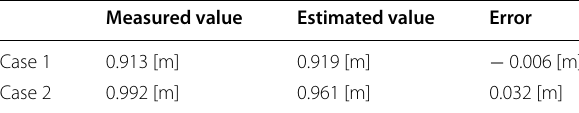
Table 1 Detection results for different peduncle